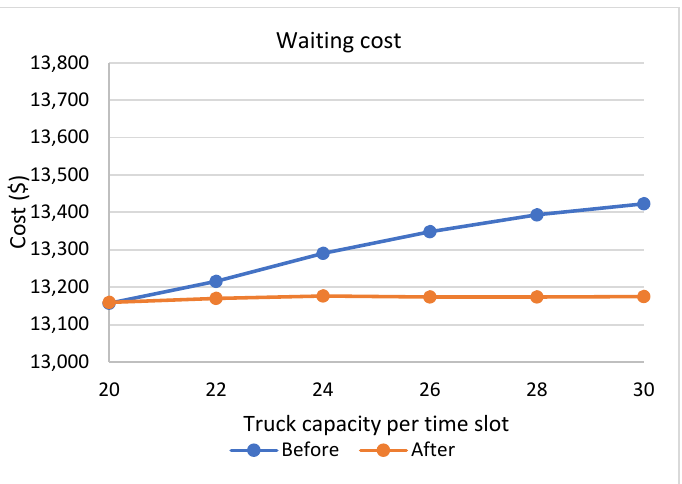
Figure 17. The difference in the waiting time cost before and after leveling the workload.